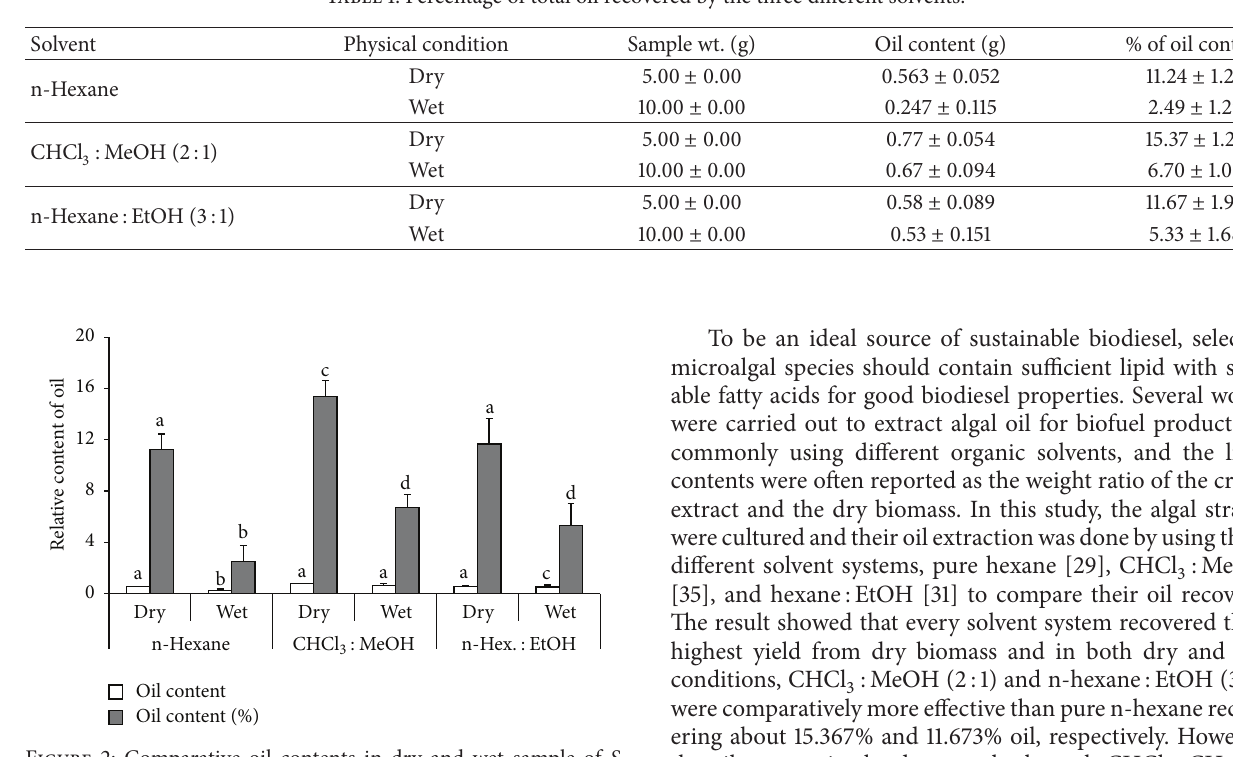
Figure 2: Comparative oil contents in dry and wet sample of S. costatum duetosolventvariation.Dataareshownasmean ± SD(a,b, c, and d) with different superscript letters over the bars for both dry and wet samples are significantly different from each other (paired 𝑡 -test, 𝑃 < 0.05